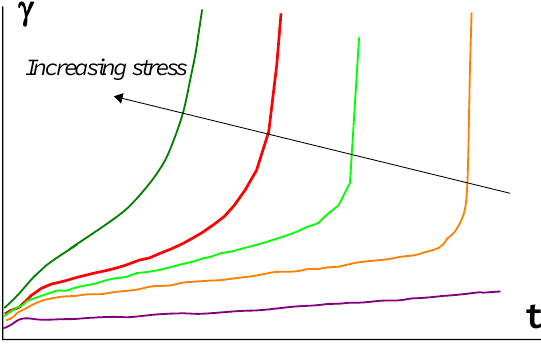
Figure 10. Time dependences of deformation for soft viscoplastic media.